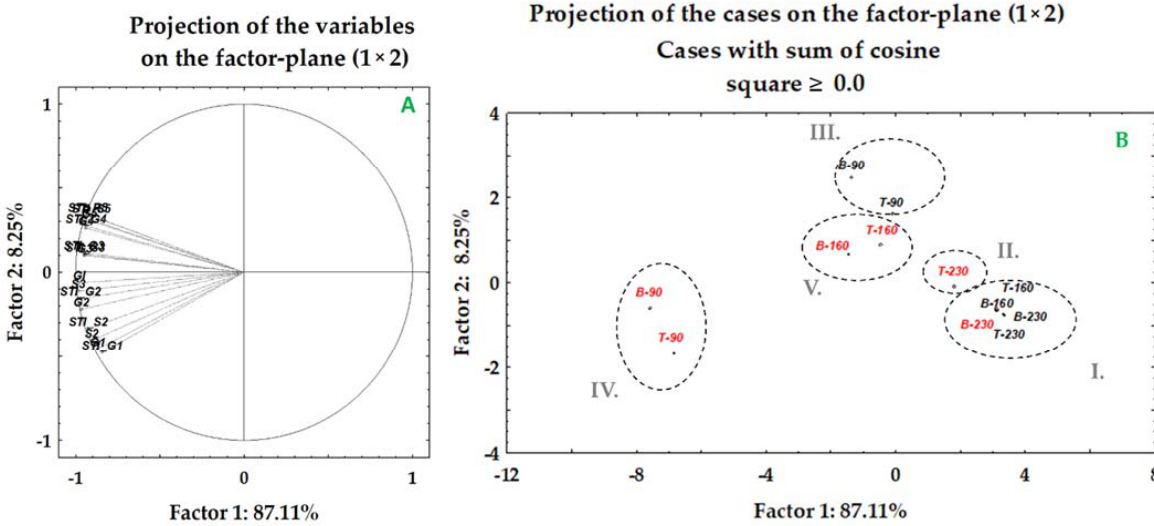
Figure 6. Principal component analysis of data sets of germination percentages (G), the germination index (GI), shoot (S) and root (R) lengths, and salt tolerance indices for germination (STI_G), shoot (STI_DT) and root (STI_R) lengths under salt treatments (90, 16 and 230 mM) and combined (P-90 mM, P-160 mM and P-230 mM NaCl) treatments. Genotypes Bernarda (B) and Tena (T). Factor loadings ( A ) and scores ( B ) of first two factors. Numbers beside each variable represent the day of treatment. Red marks represent high voltage electrical discharge (HVED) pretreatment.